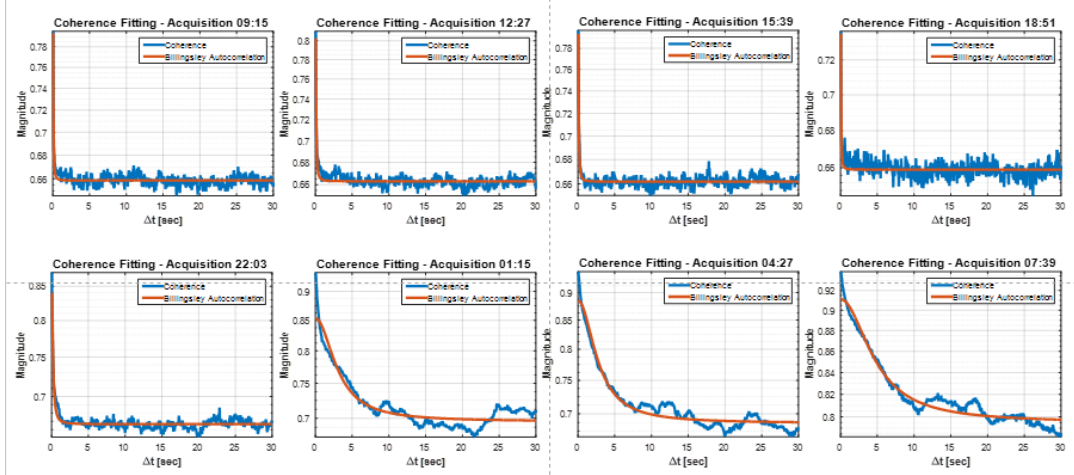
Figure 7. Operating modes of the real aperture, Ku-band radar used for the measures shown in Figures 5–9. Upper panel: example of a radar image. Lower panel: timeline, which results from interleaving every 80 s one observation at fixed pointing, named Fixed Clutter Mode (FCM), and one with an entire full aperture scan, named Scanning Aperture Mode (SAM).